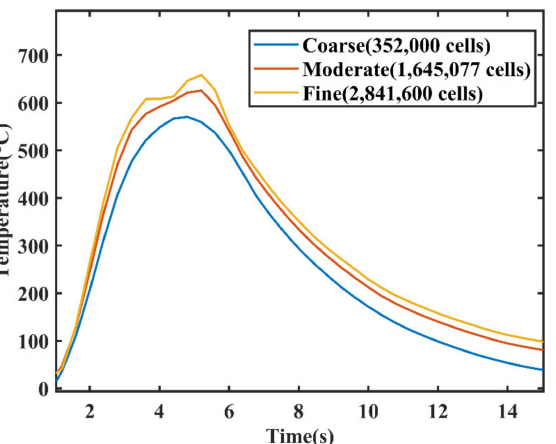
Figure 3. Comparisons of the temperature profile in location 1 fire for coarse, moderate and fine